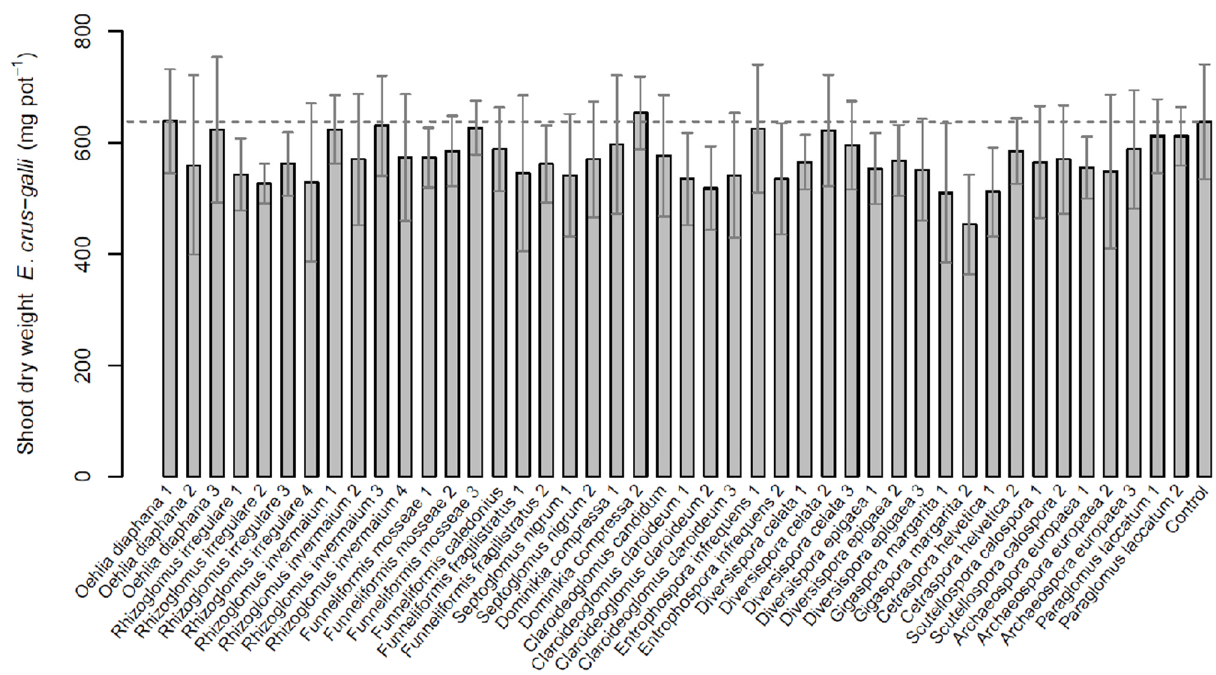
Figure 1. Aboveground dry mass of Echinochloa crus-galli inoculated with 44 different isolates of arbuscular mycorrhizal fungi (AMF) and one non-mycorrhizal control. Data are reported as means (n = 6) and their standard deviations. No significant differences among AMF isolates or the control treatment were detected via Kruskal ‒ Wallis test ( p < 0.05).